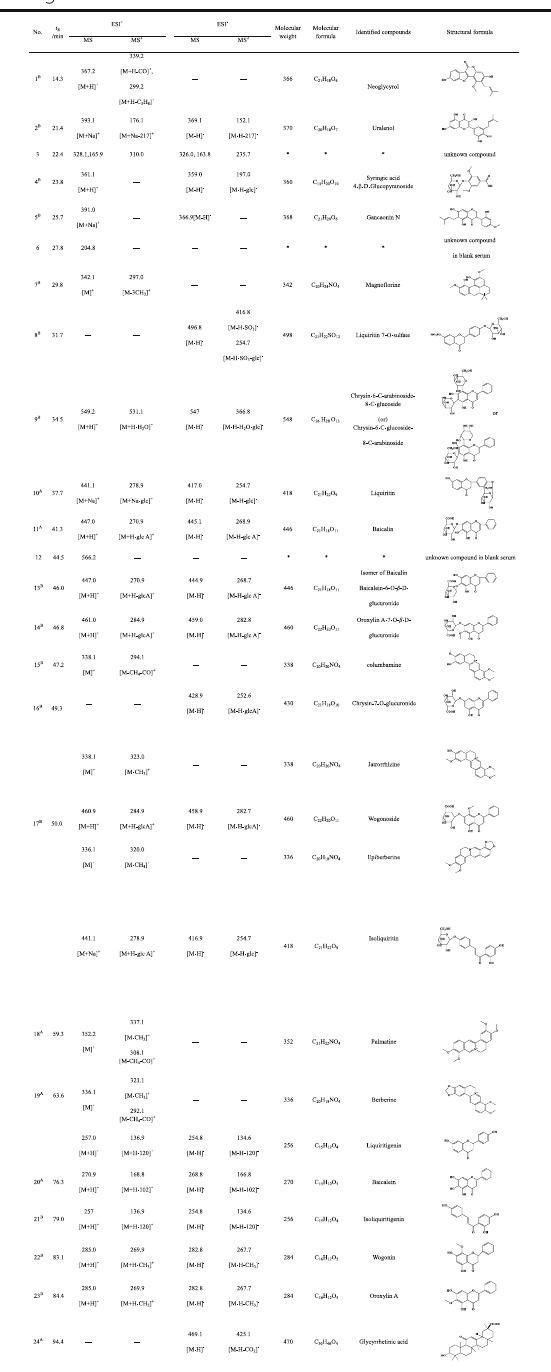
Table 2 MS/MS data of (+) ESI-MS spectra and ( − ) ESI-MS spectra, and the identification results of the constituents of Erhuang